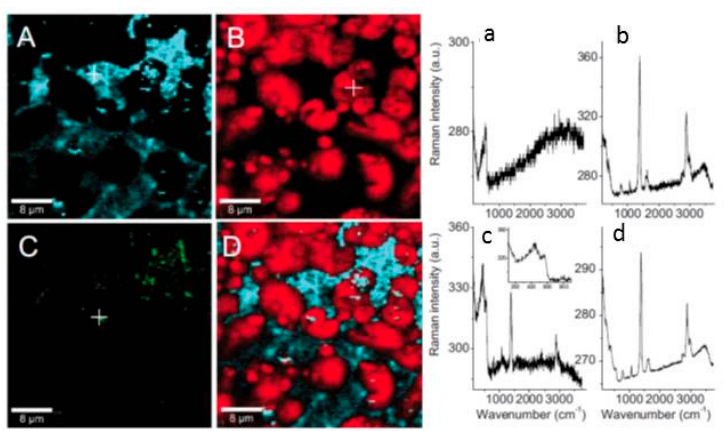
Figure 14. Left: Color-coded Raman images for zinc exposed to 100 ppb formic acid in humid air (90% RH) for 2 h (upper part) and 48 h (lower part). ( A ): ZnO (integrated 300–620 cm − 1 ); ( B ): CH in Zn hydroxy formate (2850–3000 cm − 1 ); ( C ): more crystalline ZnO (380–480 cm − 1 ); ( D ): the combination of the Raman images in A – C . Right panel ( a – c ): Raman spectra corresponding to the marked spots in the color-coded images. ( d ) is the average over the whole image. The image size is 40 × 40 microns. Reproduced from reference [106] by permission of The electrochemical Society. Copyright 2010.